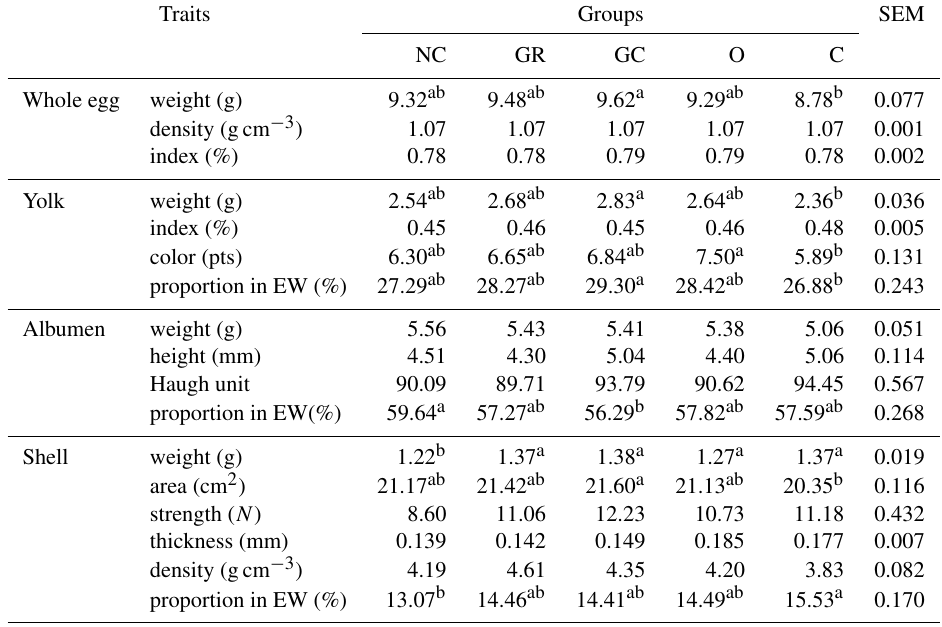
Table 3. Egg quality of Japanese quails influenced by in ovo injection with aqueous solutions of plant extracts (at seventh week of birds’ life, 24 eggs per group, 120 eggs in